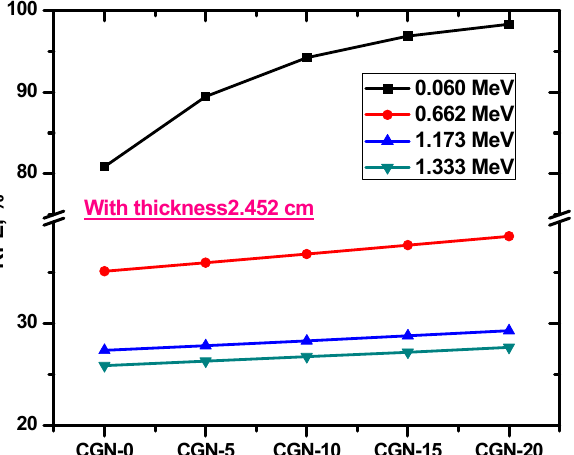
Figure 13. The radiation protection efficiency (RPE) for the prepared mortars with a thickness of 2.452 cm.